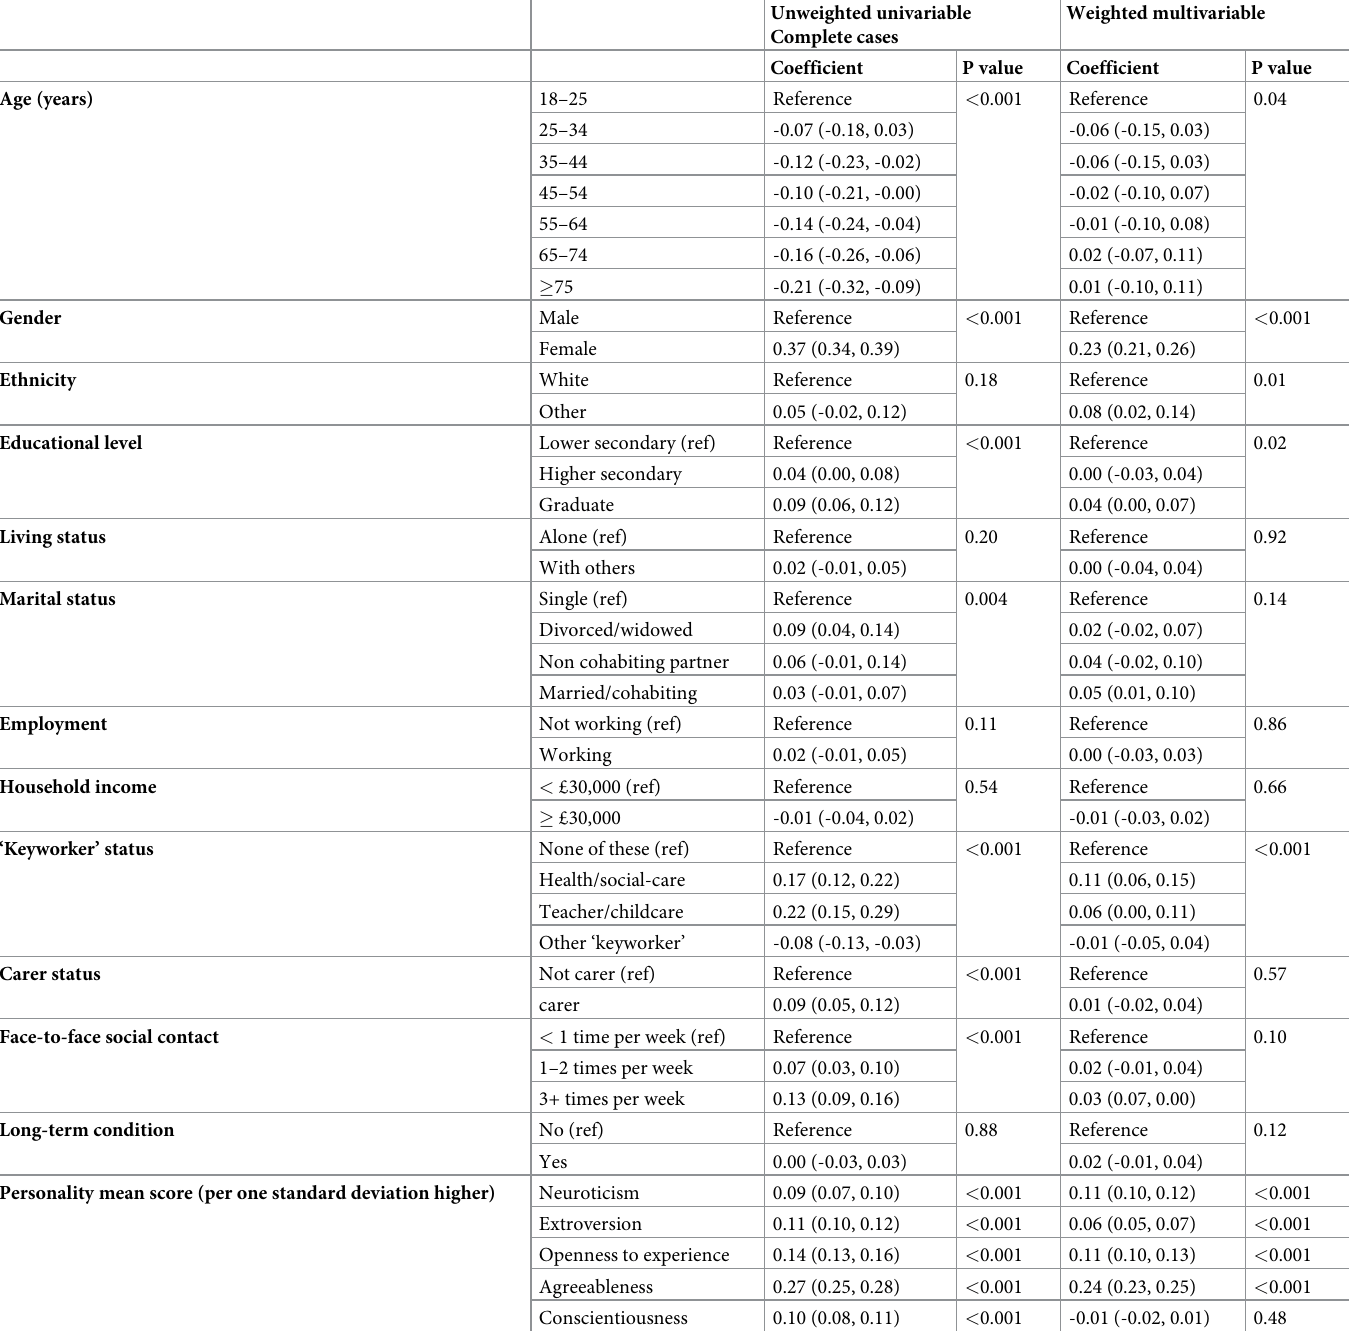
Table 3. Association of participant characteristics with empathic concern (n =